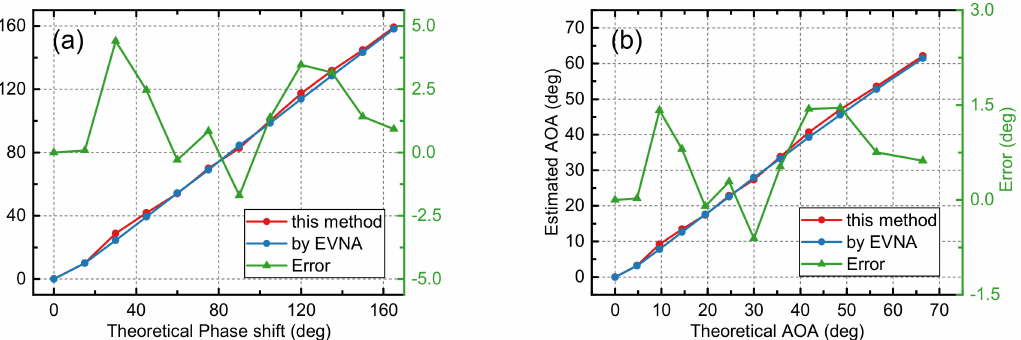
Figure 7. ( a ) Phase shift and ( b ) AOA measured by this method, EVNA, and the corresponding measurement